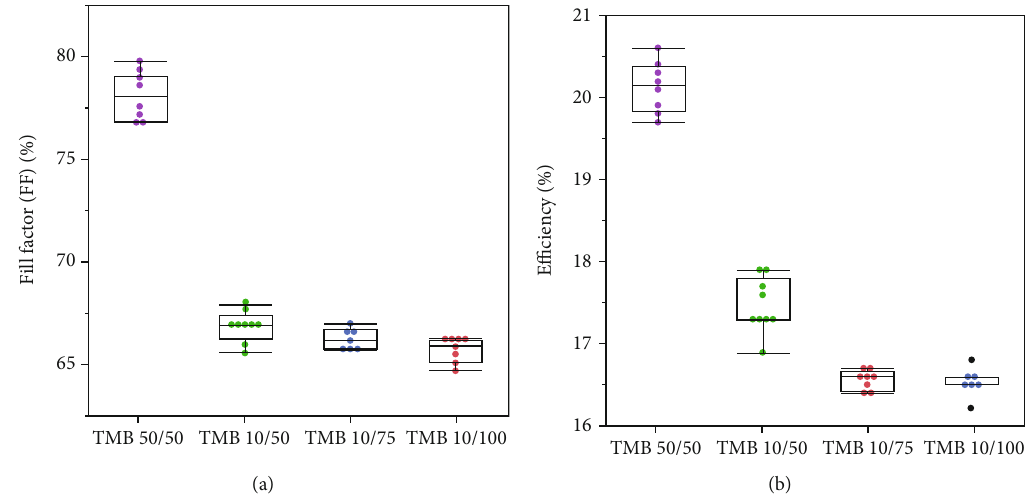
Figure 9: Box plots of the distribution of the fi ll factor ( FF ) and e ffi ciency of the cells from the di ff erent splits.